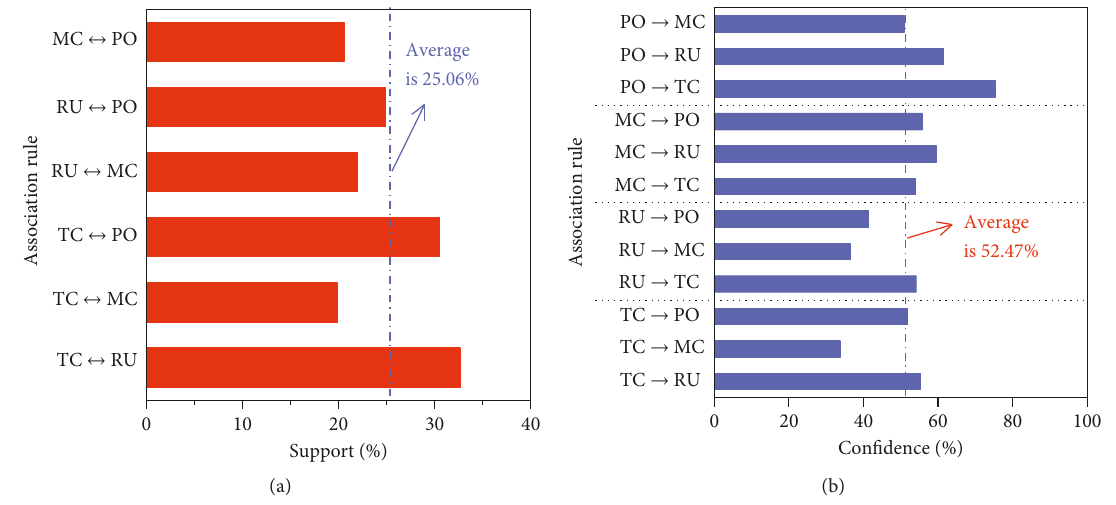
Figure 6: Association rules among IDDTs. (a) Supports in IDDTs. (b) Confidences in